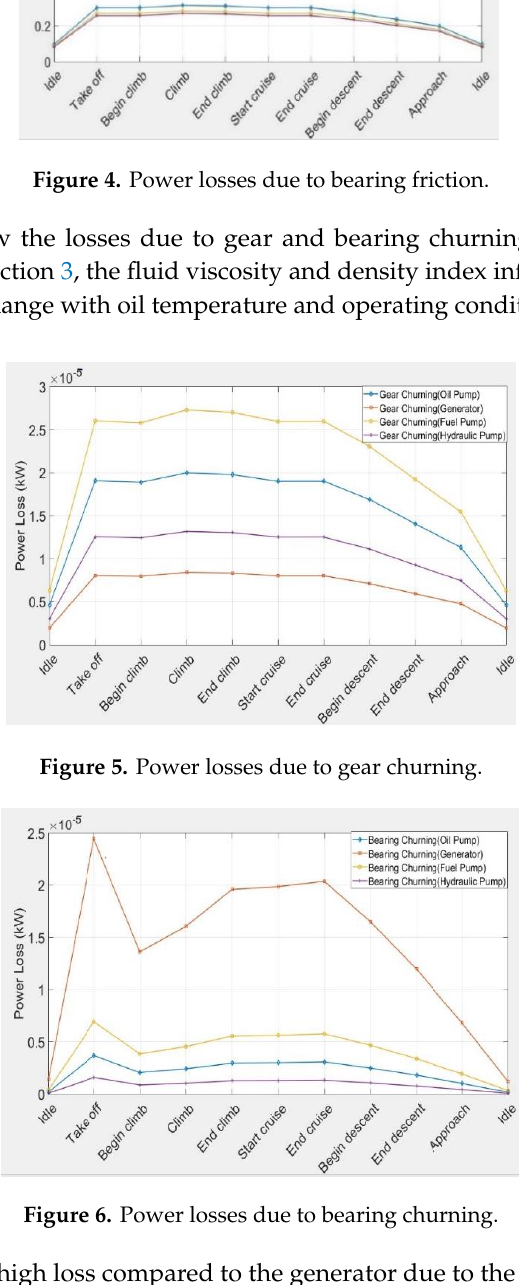
Figure 4. Power losses due to bearing friction.